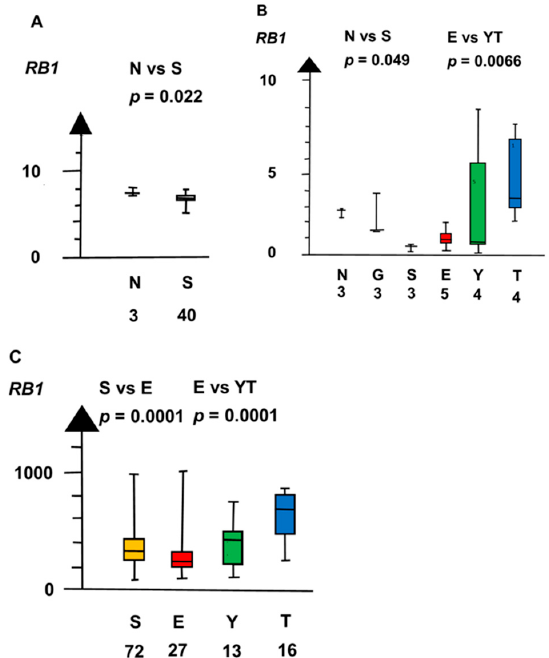
combined (median 0.5 vs. 2.3, p = 0.0495, Kruskal–Wallis test), as shown in Figure 8.